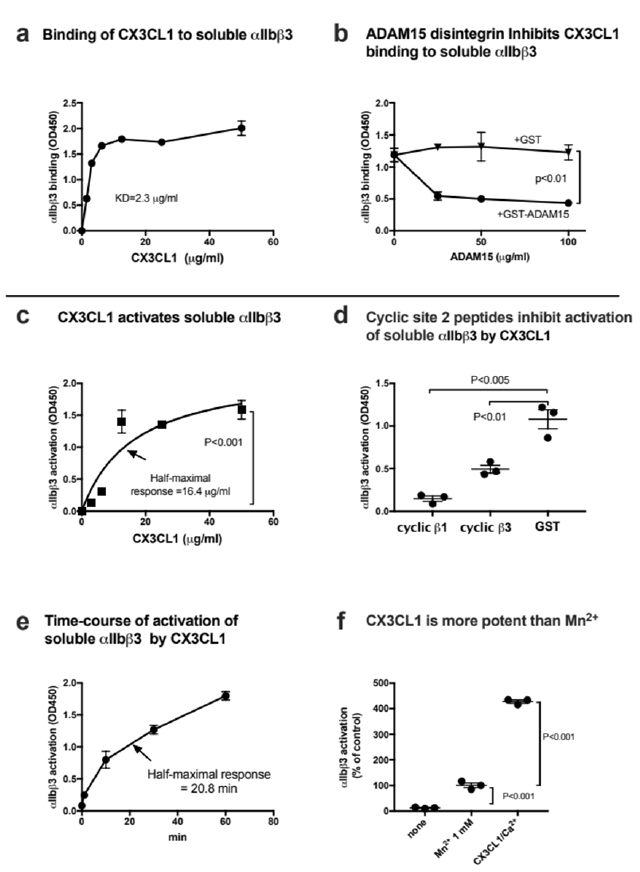
Figure 5. CX3CL1 binds to and activates soluble integrin αIIbβ3 in cell -free conditions. ( a ) Binding of soluble integrin αIIbβ3 to CX3CL1 in 1 mM Mn 2+ in cell-free conditions. Wells of 96-well microtiter plates were coated with CX3CL1 and remaining protein-binding sites were blocked with BSA. Wells were incubated with soluble αIIbβ3 (1 μg/mL) in Tyrode-HEPES buffer with 1 mM Mn 2+ (to activate αIIbβ3) for 1 h at room temperature. After washing the wells to remove unbound integrin, bound αIIbβ3 was quantified using anti-β3 mAb (AV10) and HRP-conjugated anti mouse IgG. Data